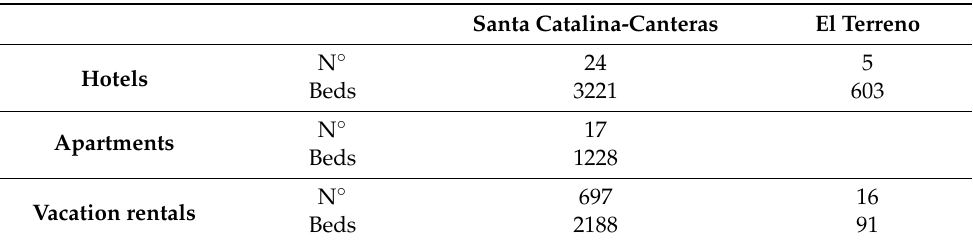
Table 1. Touristic offer in Santa Catalina-Canteras and El Terreno. Source: Own elaboration, based on Listings of Accommodation Establishments (Tourism Boards of Mallorca and Gran Canaria).